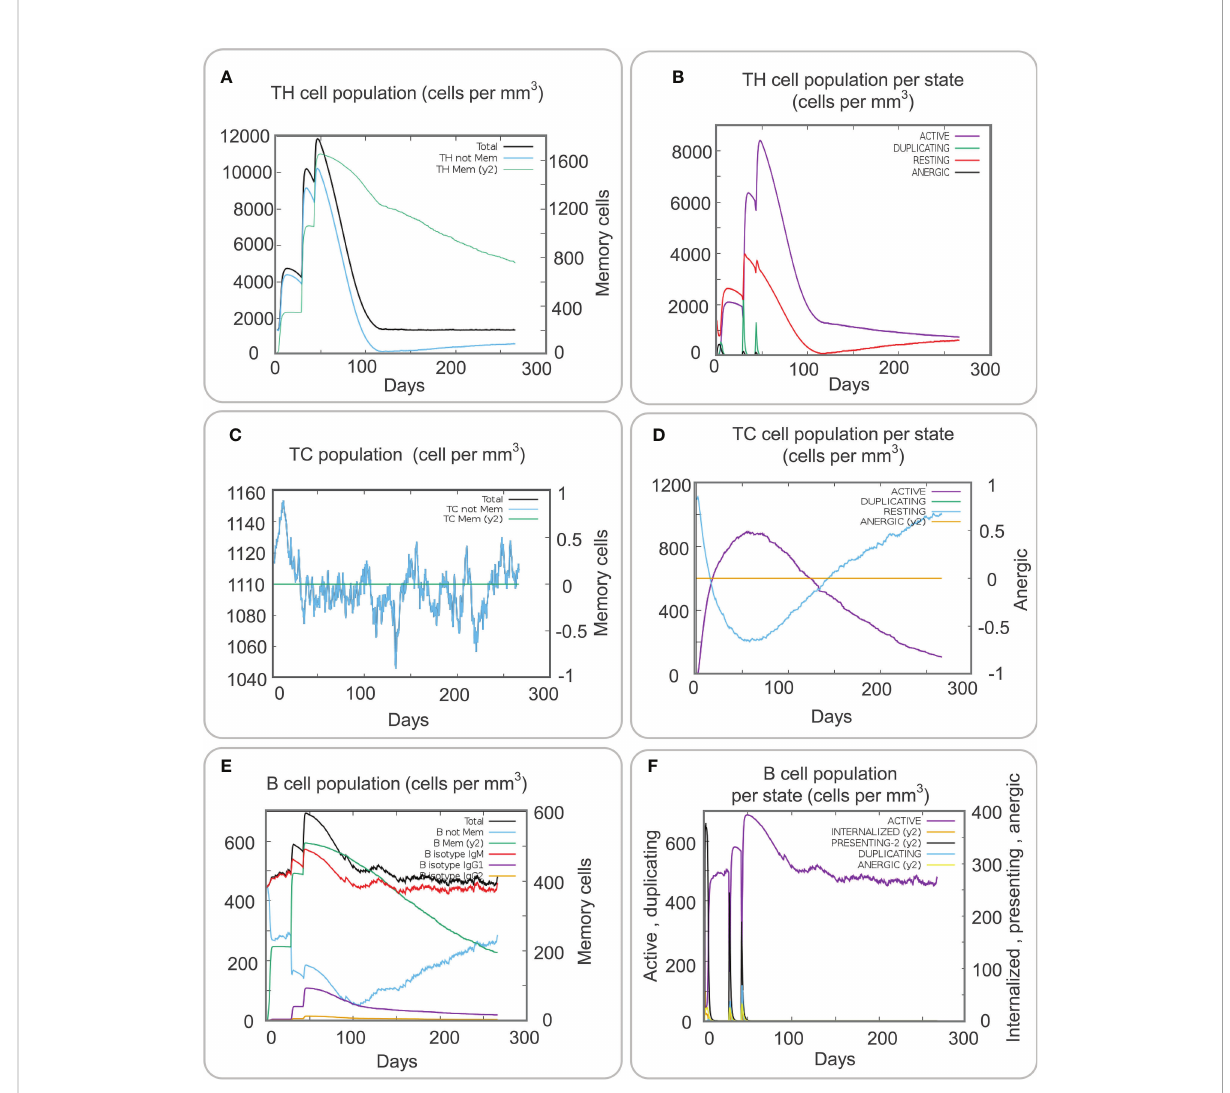
FIGURE 6 Immune stimulation of adaptive immune cells predicted by the C-ImmSim Server. (A) The TH cell population. (B) The TH cell population per state. (C) The Tc cell population. (D) The Tc cell population per state. (E) The B cell population. (F) The B cell population per